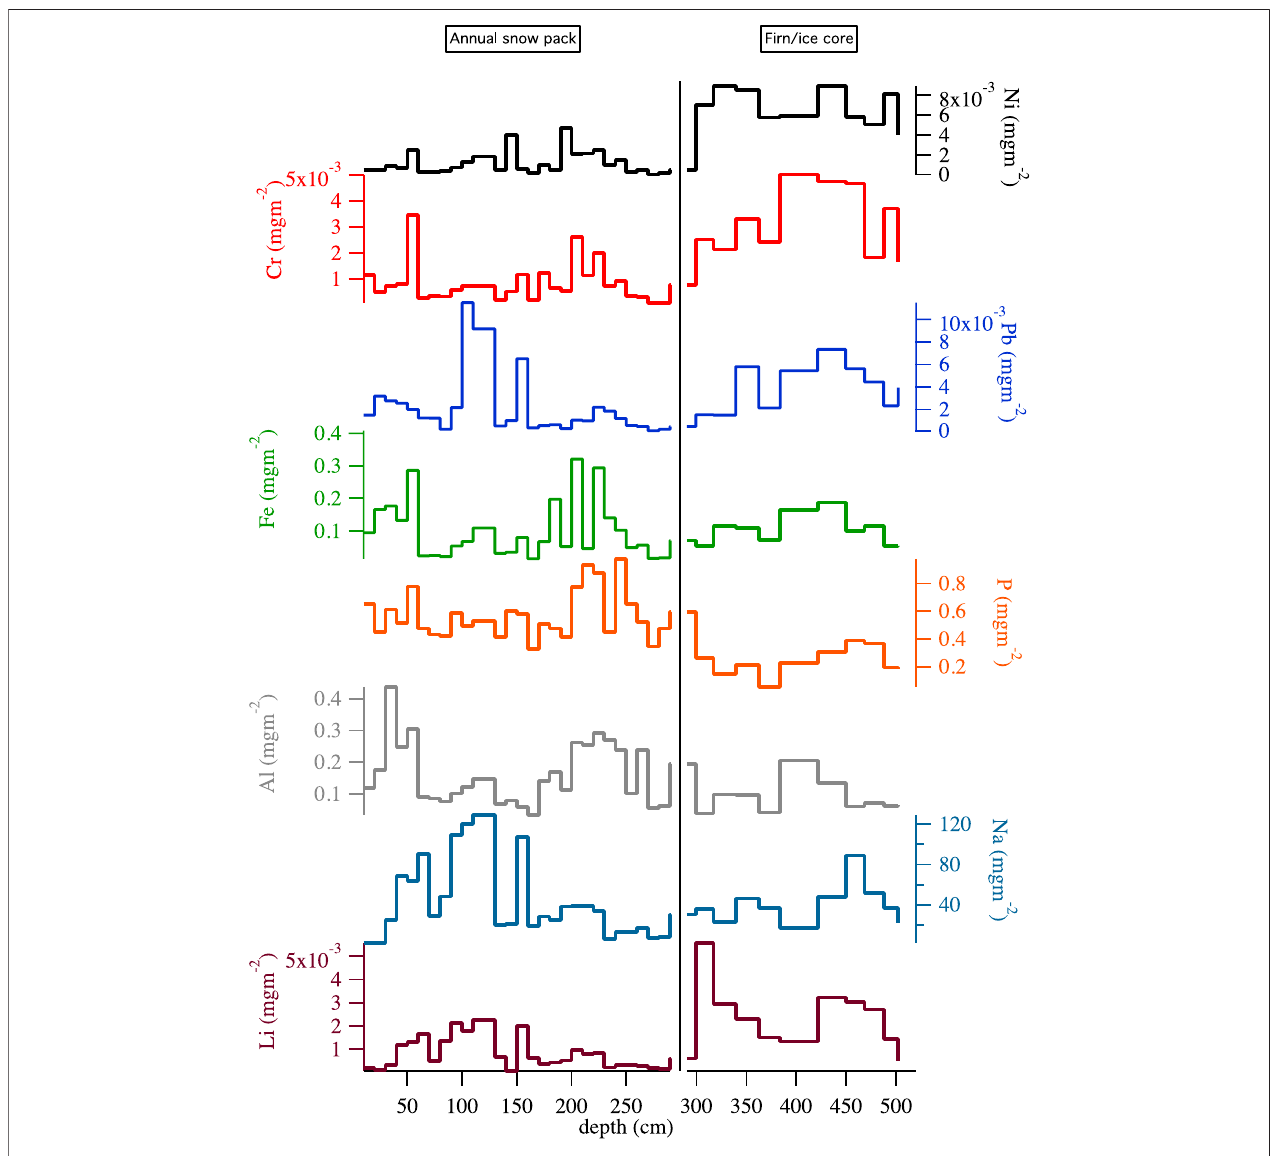
FIGURE 2 | Snowpack sample flux (left panels) versus fi rn sample fl ux (right panels) of selected elements for the three groups. Lithium, Ni, Cr, and Pb are representativeofthethirdgroup(Bi,Se,Ca,K,U,Pb,Rb,Tl,Li,Co,In,Cr,Mn,Zn,Ni,andCd),FeandNaofthesecond(B,V,Na,Ti,Fe,andCe)andAlandPofthethird (Mo, P, Mg, Th, Sr, Al, Ba, and As). The left and right axis units are both mg m − 2 , lower axis represents the depth (in cm) from the annual snowpack surface.